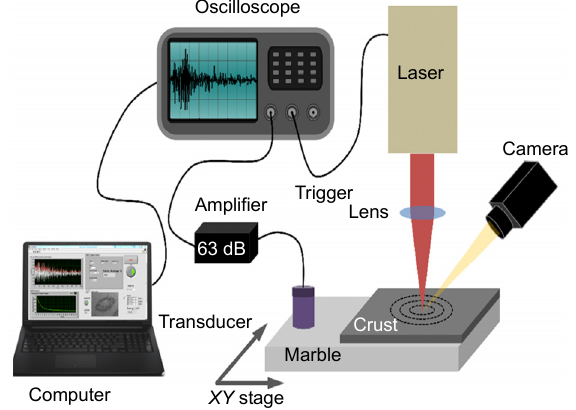
Fig. 1 | Schematic representation of the hybrid photoacoustic and optical experimental